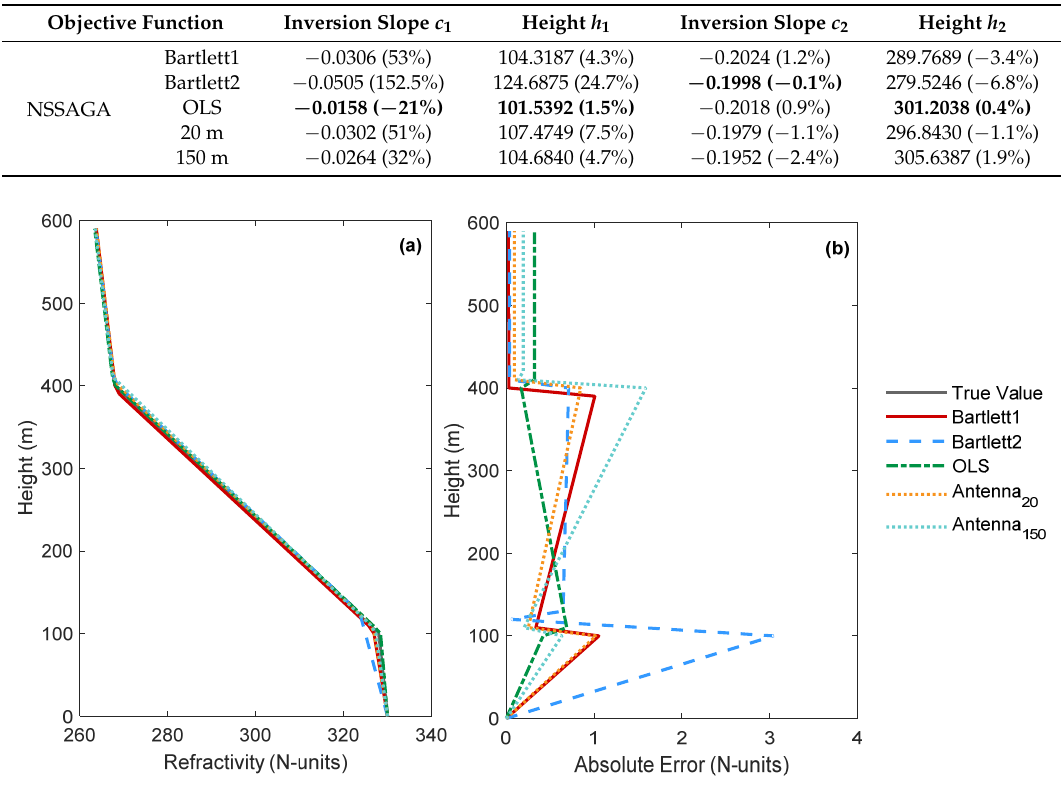
Table 3. The value of inversion parameters by NSSAGA with different objective functions (bold font indicates best retrieved parameters).